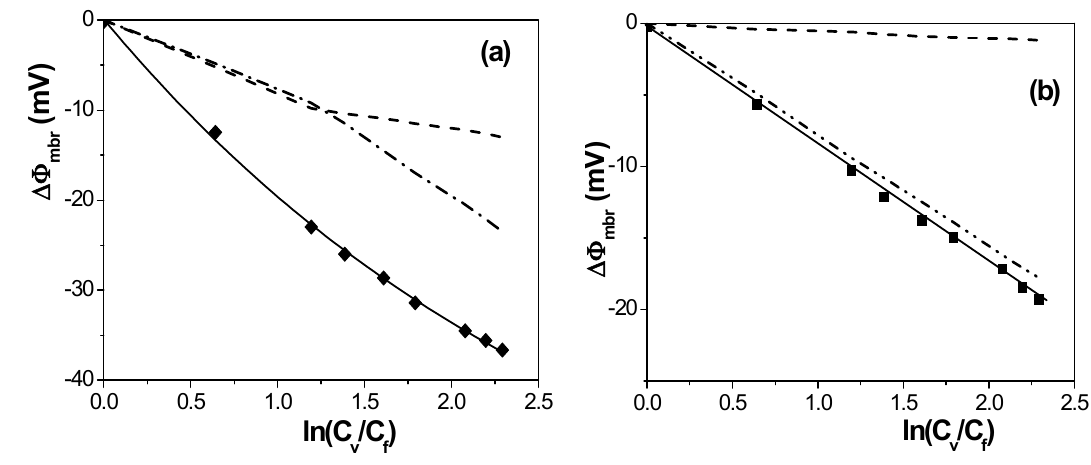
Figure 4. Experimental (symbols) and fitted (solid lines) membrane potentials as a function of solution concentration ratio, plus calculated values for Donnan (dashed lines) and diffusion (dashed-dot lines) contributions determined using Equations (1) and (2) and parameters in Table 2: ( a ) Al-Sf membrane; and ( b ) Anopore membrane.